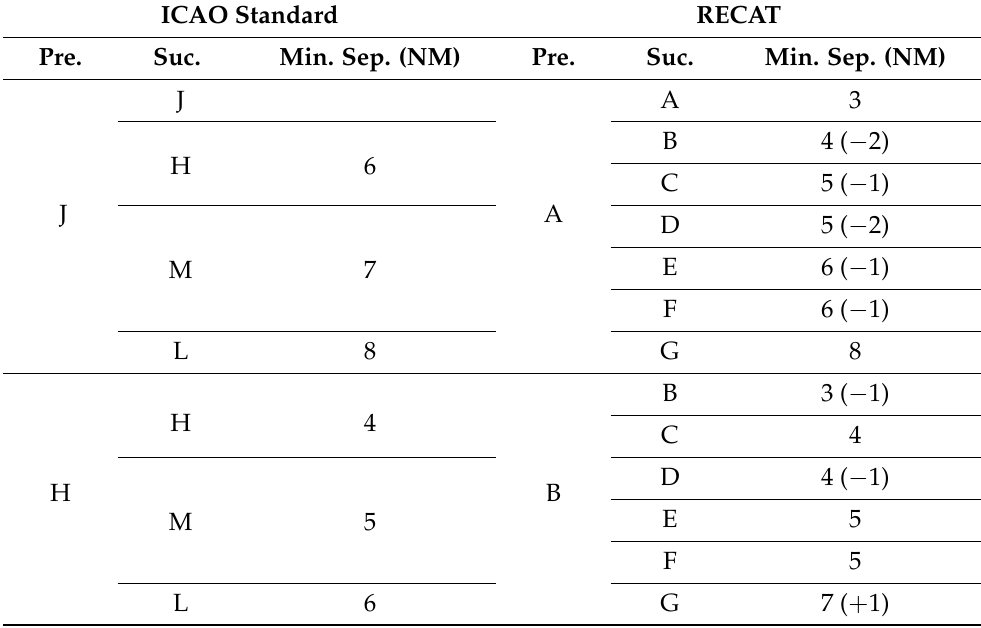
Table 2. Distance-based wake turbulence separation minima (Min. Sep.) between preceding (Pre.) and succeeding (Suc.) aircraft based on wake turbulence categories with two standards. The blank separation minima and the separation minima of other pairs of aircraft are determined according to Minimum Radar Separation